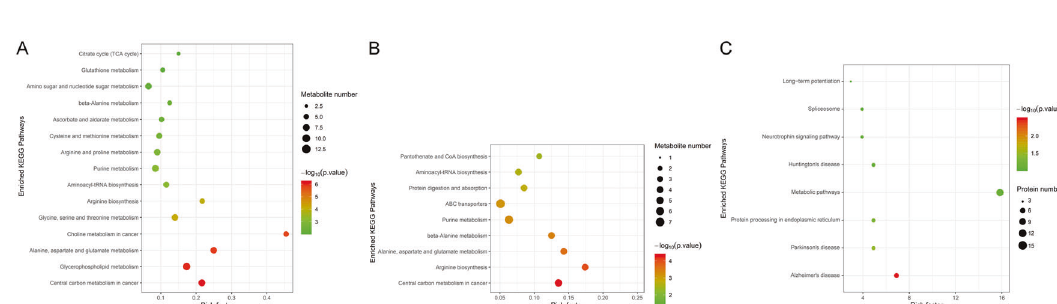
Fig. 4 Pathway characteristics of frontal-posterior functional imbalance in MAM rats. A Pathways of metabolomic pro fi les in the PFC between vehicle rats and MAM rats. The metabolites are enriched in the central carbon metabolism pathway. B Pathways of metabolomic pro fi les in the OC between vehicle rats and MAM rats. The metabolites are enriched in the central carbon metabolism pathway. C Pathways of proteomic pro fi les in the prefrontal cortex between vehicle-sham rats and MAM-sham rats. The signi fi cant network was the “ Alzheimer disease pathway ” . MAM methylazoxymethanol acetate, PFC prefrontal cortex, OC occipital cortex, KEGG Kyoto Encyclopedia of Genes and cycle, alanine, aspartate and glutamate metabolism, glycine, serine and threonine metabolism, arginine biosynthesis, glycer-